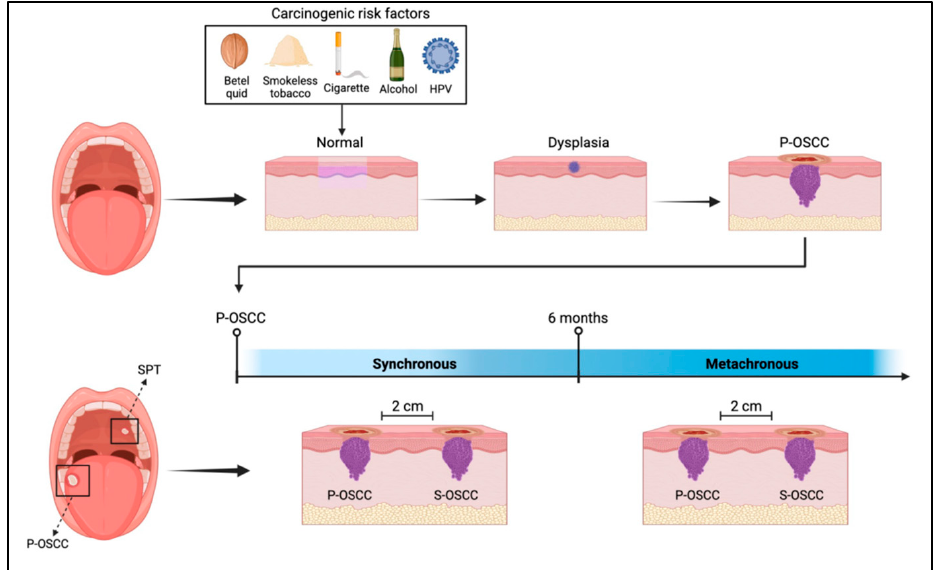
Figure 1. Shows the development of OSCC post-exposure to carcinogenic risk factors; If SPT was discovered before or after six months of P-OSCC development, it would be considered synchronous or metachronous,